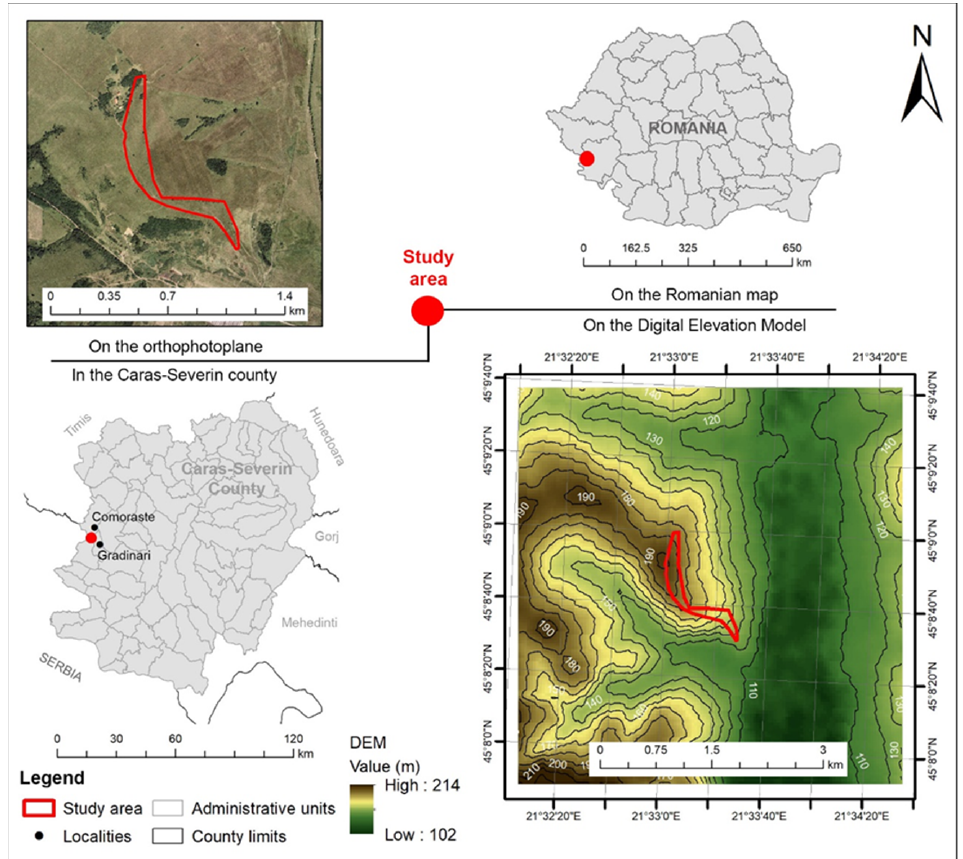
Figure 10. Localization of the study area (designed by Cop ă cean L. using data from Geo-spatial.org) [80], ANCPI [81], EEA–EU-DEM [82]. The study area is located in the southwest part of Romania, on the territory of Cara¸s- Severin County, at a distance of 2 km from the border with the Republic of Serbia. The experimental site (45 ◦ 8 (cid:48) 40” N, 21 ◦ 33 (cid:48) 20” E) has a surface of 10 hectares and is located in the Tirolului Hills. According to the data obtained by the processing of the Digital Elevation Model (DEM) [82] using methods and techniques specific for the Geographic Informatic Systems (GIS) [83], it was noticed that the experimental site is placed at elevations com- prising 127–191 m, with the average altitude of 170 m a.s.l. Because the area is hilly (see Figure 10), the slope varies between 2.4 and 16.3%, with an average value of 9.4%.